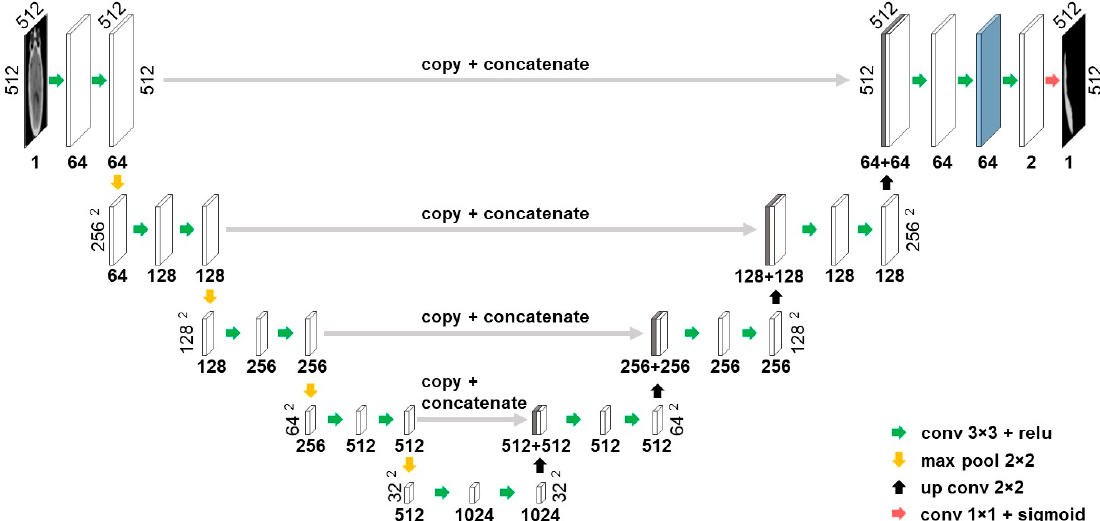
Figure 5. Illustration of the baseline U-net architecture used for segmentation. The activations of the layer marked in blue are used as deep features.